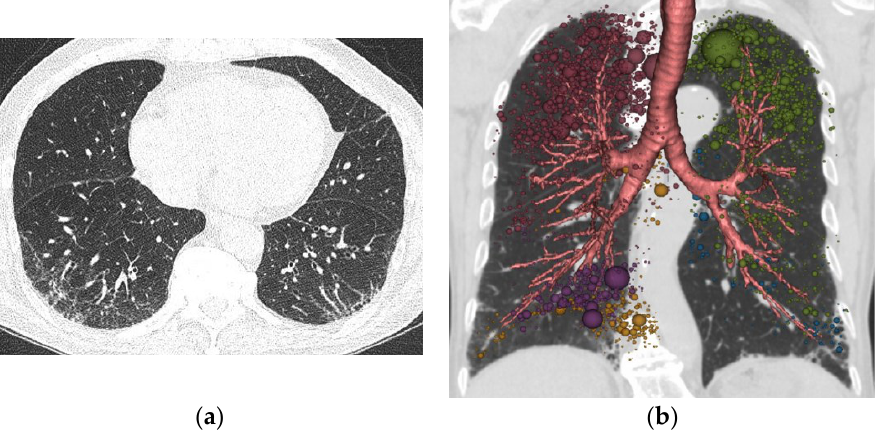
Figure 3. ( a ) 78-year-old man who belonged to the moderate smoking group. A. Chest CT shows ground-glass opacity with reticular opacity in predominantly subpleural area of posterobasal segment, both lower lobe; ( b ) Quantitative data from chest CT shows upper lobe predominant emphysema with a quantified low attenuation area (LAA I-950 : 1.62%) and Pi10 (3.81 mm).